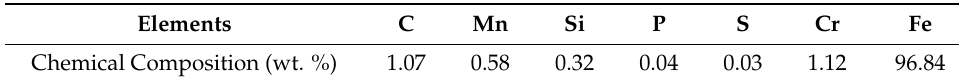
Table 1. Chemical composition of EN 31 Tool Steel.